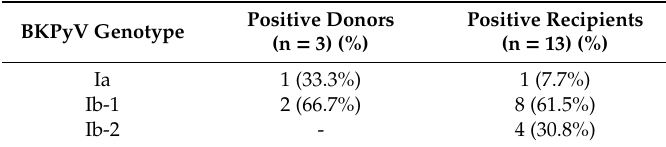
Table 7. BK Polyomavirus (BKPyV) genotypes distribution in urine samples from kidney transplant donors and